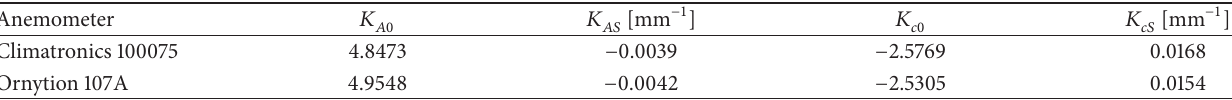
Table 4: Fitting coefficients of the linear approximation to parameters 𝐾 𝐴 and 𝐾 𝑐 (see expressions (55)) from the Climatronics 100075